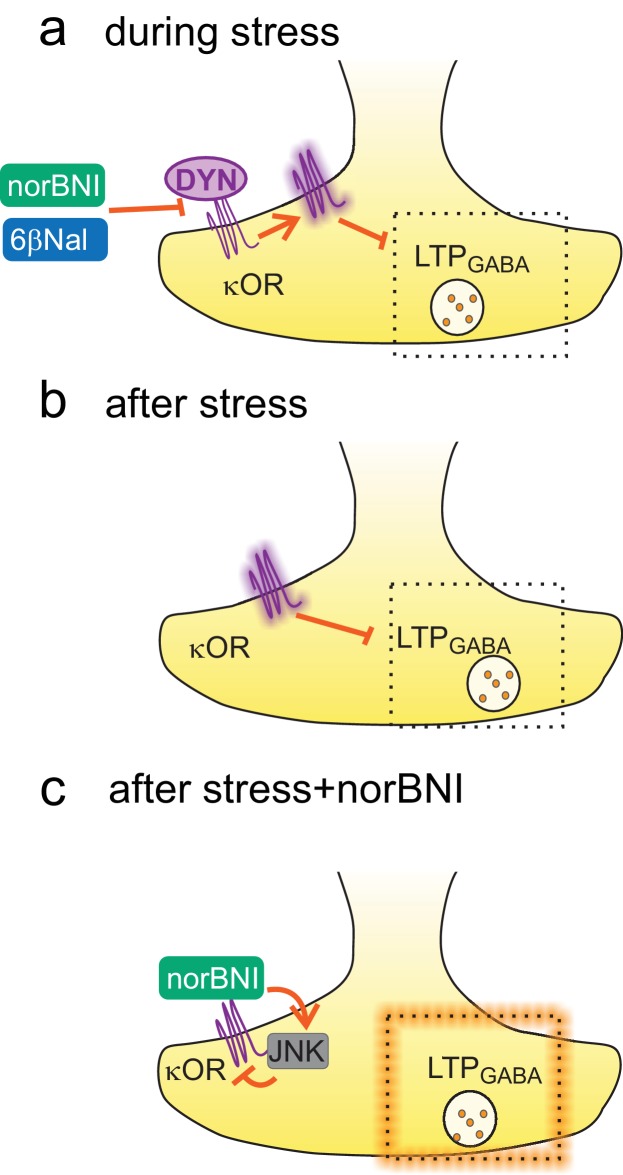
Constitutive activation of κORs by stress.(A) During stress, dynorphin binding to the κOR triggers a shift to a constitutively active state. By blocking dynorphin binding, both norBNI and 6β-naltrexol prevent the loss of LTPGABA during this time. (B) After stress, the block of LTPGABA is maintained by constitutive activity of κORs and is no longer dependent on dynorphin binding. (C) norBNI reverses the stress-induced block of LTPGABA by activating the JNK signaling pathway which non-competitively reduces κOR activity.